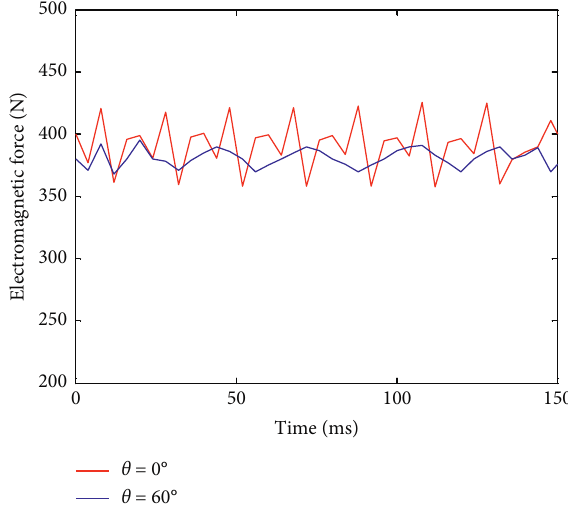
Figure 13: Electromagnetic force varies with time.